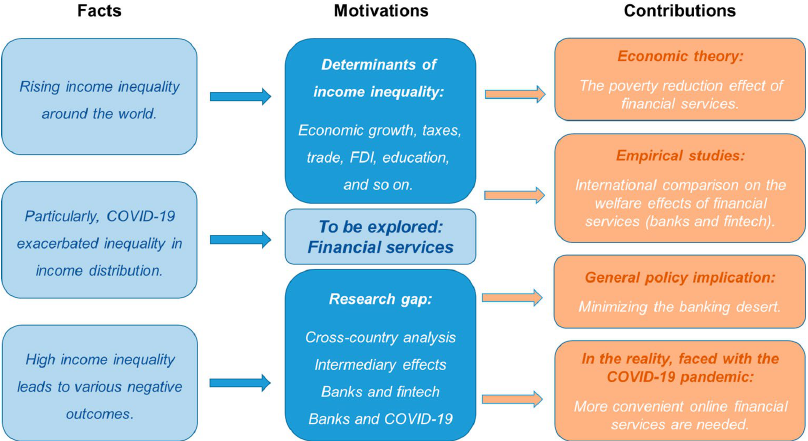
Figure 1. Summary of the